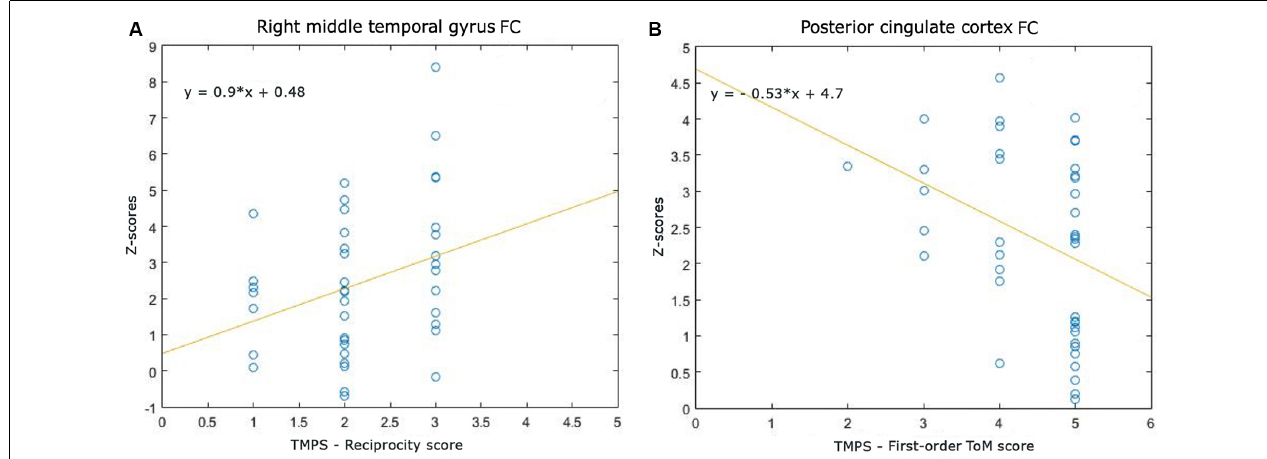
FIGURE 3 | Scatterplots of associations between resting-state functional connectivity (FC) of DMN abnormalities and ToM tasks in MS patients. (A) Association between right middle temporal gyrus FC and reciprocity score of TMPS; (B) Association between posterior cingulate cortex (PCC) FC and first-order ToM score of TMPS.